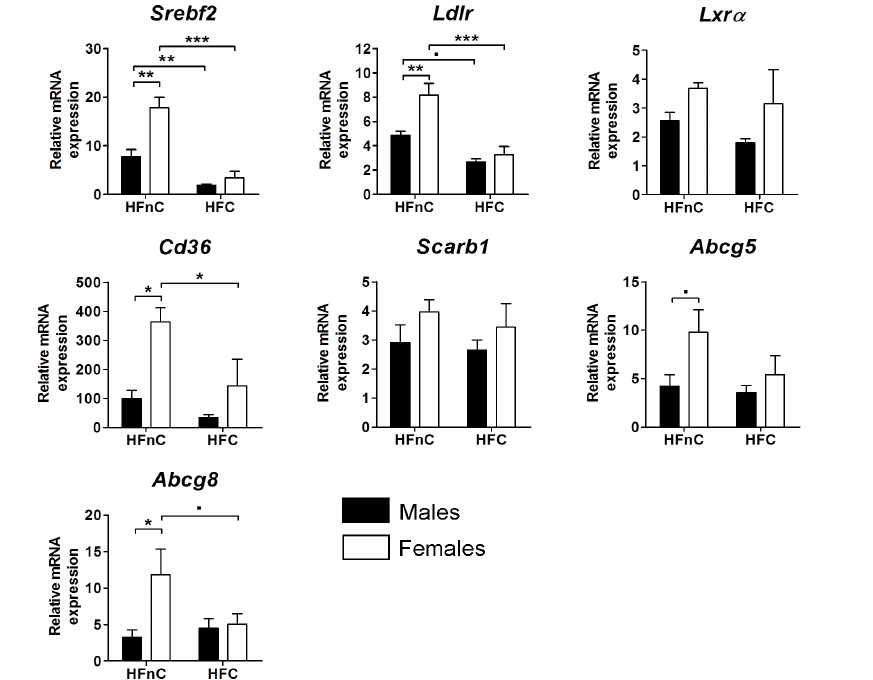
Figure 4. Relative mRNA expression of cholesterol-related genes in the liver. Black columns represent male and white columns female mice. Error bars represent SEMs. N = 5; ˙ p < 0.1; * p < 0.05; ** p < 0.01; *** p <